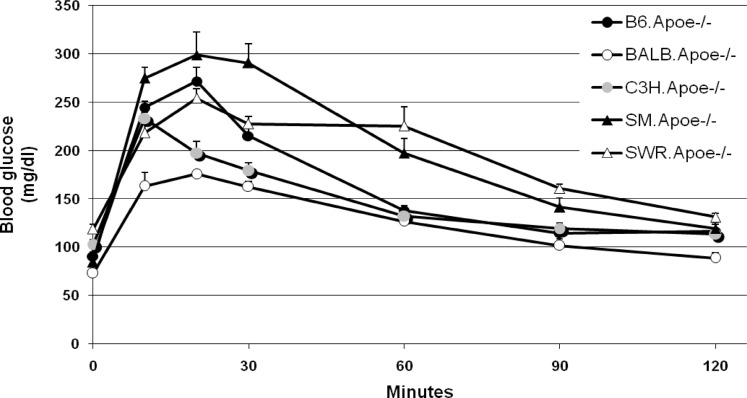
Glucose tolerance test (GTT) for five Apoe-/- mouse strains fed a Western diet.For the test, overnight fasted mice were subject to an intraperitoneal injection of glucose (1 g/kg). Blood glucose concentrations were determined with a glucometer using blood taken from cut tail tips at the indicated time points. Values are means ± SE of 5 to 16 mice. When compared to B6 mice, all strains show statistical significance.